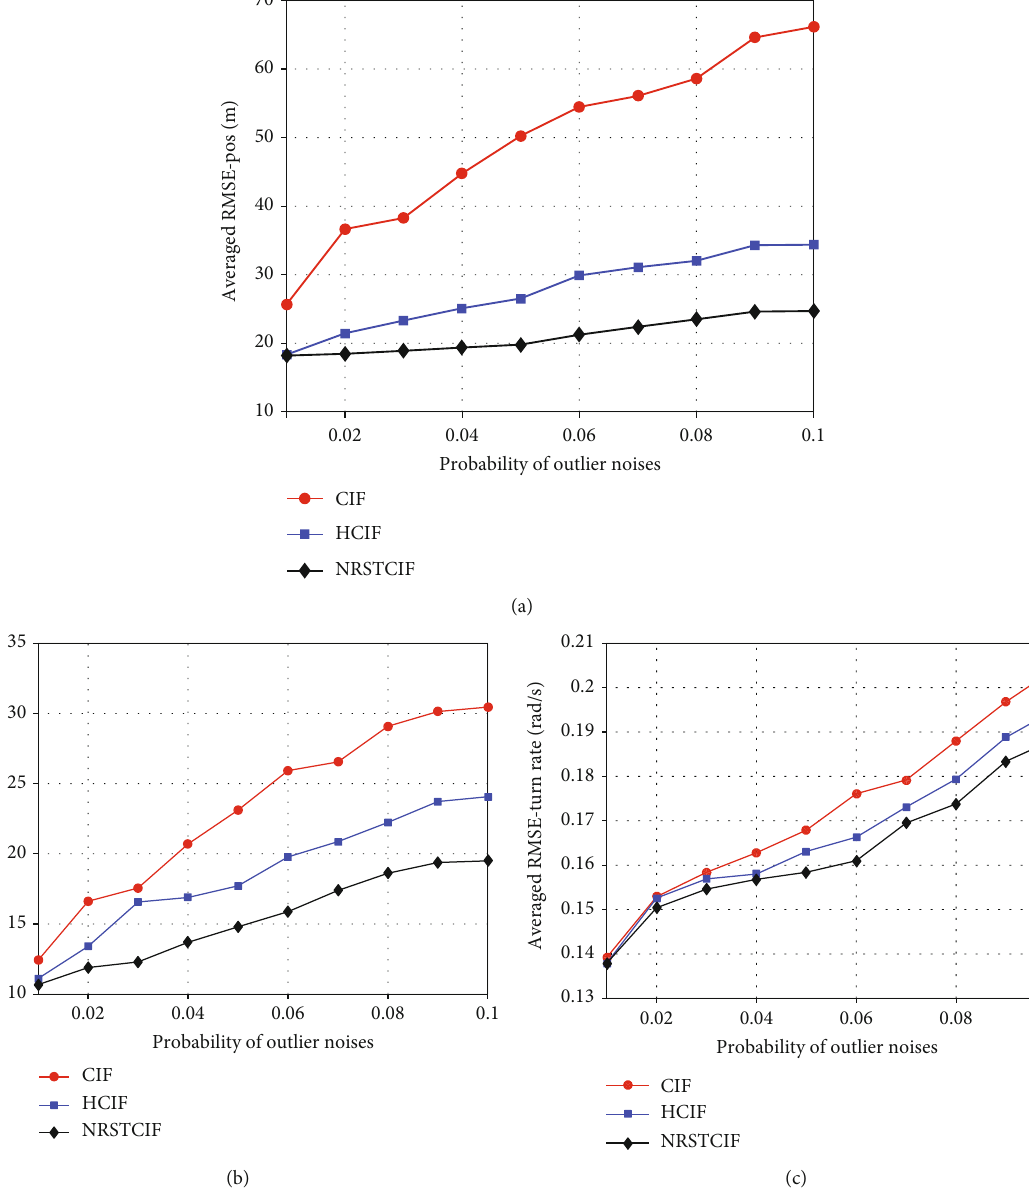
Figure 4: Performance comparison of three fi lters with di ff erent probabilities of outlier. (a) Position estimation error. (b) Velocity estimation error. (c) Turn rate estimation